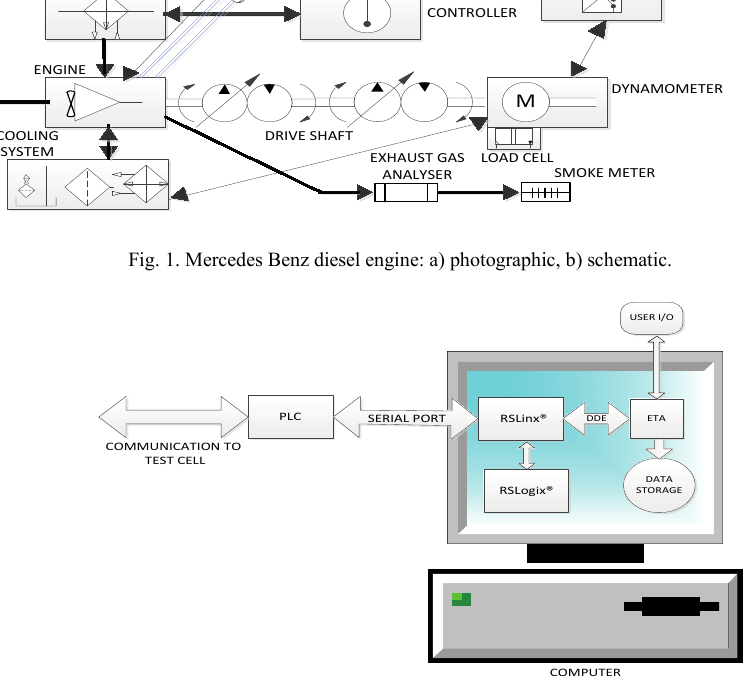
Fig. 2. Schematics of the test cell